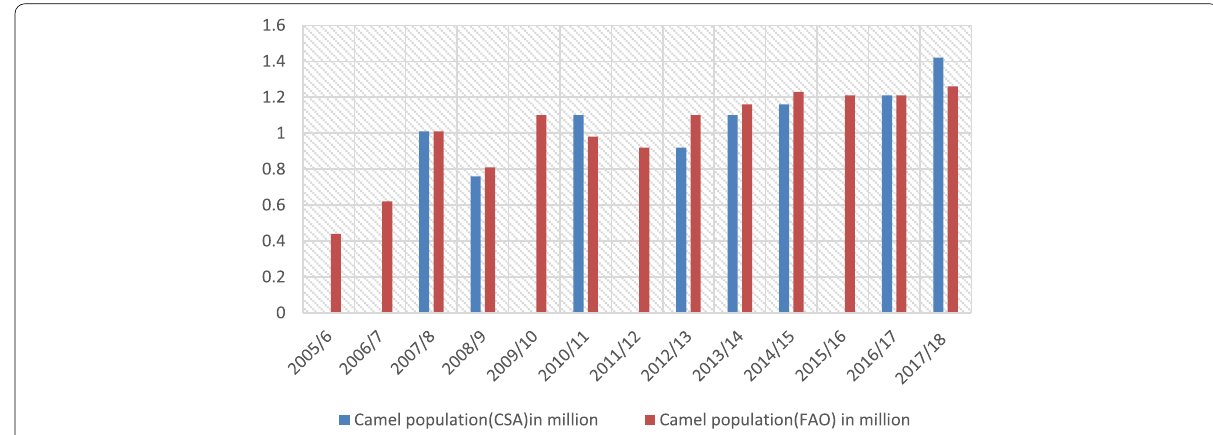
Fig. 1 Trend of the camel population in Ethiopia by FAO and CSA. Source: author computation from FAO STAT and